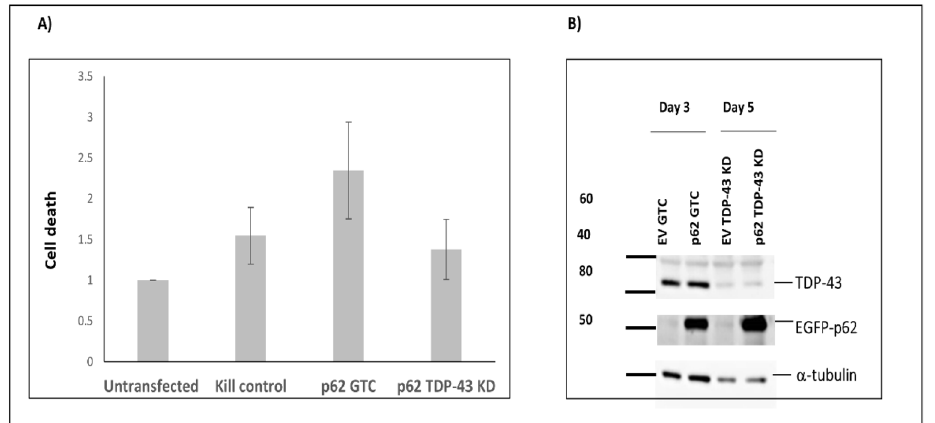
Figure 9. p62-mediated neuronal death is independent of TDP-43 expression. (A) Cells were transfected with a PMO to knock-down TDP-43 (TDP-43 KD) or a standard control (GTC). The following day cells were transfected with EGFP-p62 and 48 h later trypsinised, incubated with Sytox-Red and then assessed for cell viability by flow cytometry. (B) Cells were harvested at 3 and 5 days post transfection with PMOs and western blots performed as